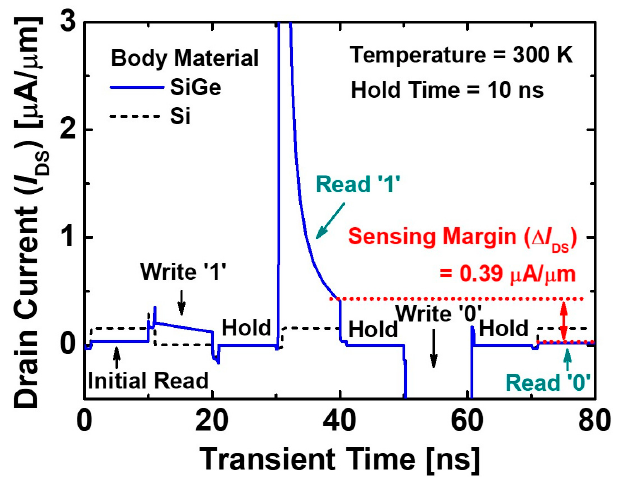
Figure 3. Transient characteristics of the GAA-JLFET-based 1T-DRAMs with different body materials at the temperature of 300 K. The read/hold/write operation time is 10 ns.